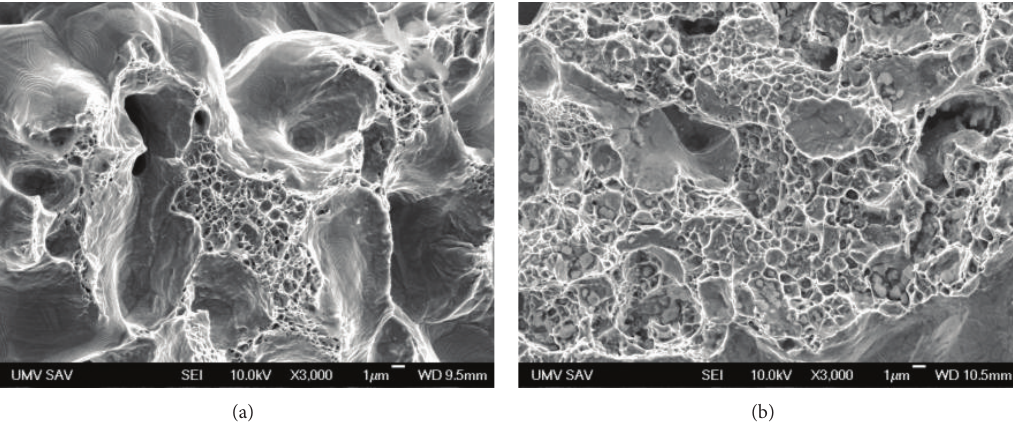
Figure 8: Fracture surface of the fractured AstCrM + 0.5% C components with densities of (a) 6.5 and (b) 7.4g/cm 3 sintered at 1120 ∘ C for 30 min.